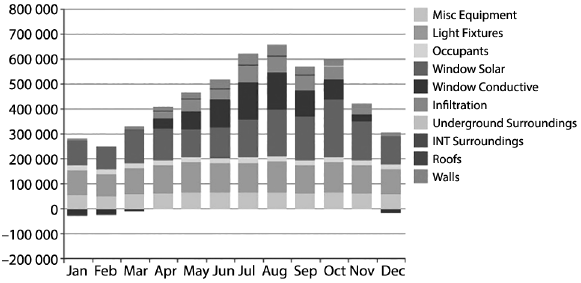
Figure 15. Summary of monthly energy load